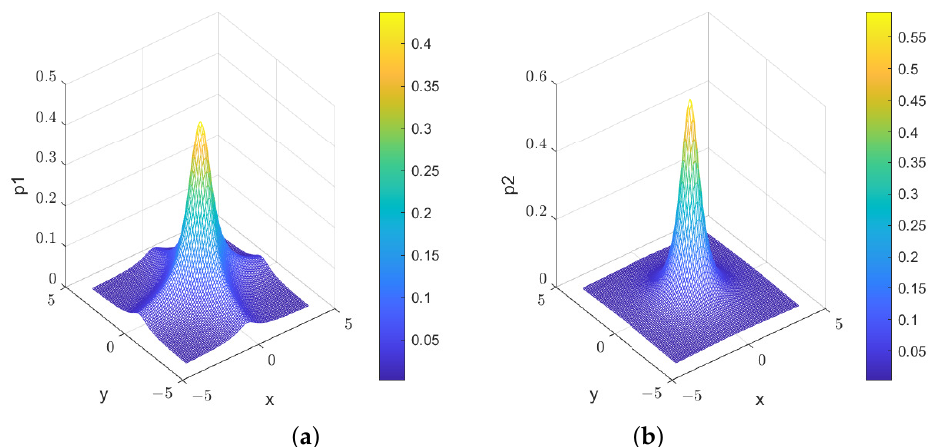
Figure 1. Pdfs of the proposed model and CMSt in the 2D example. ( a ) Pdf plot of the proposed model. ( b ) Pdf plot of the